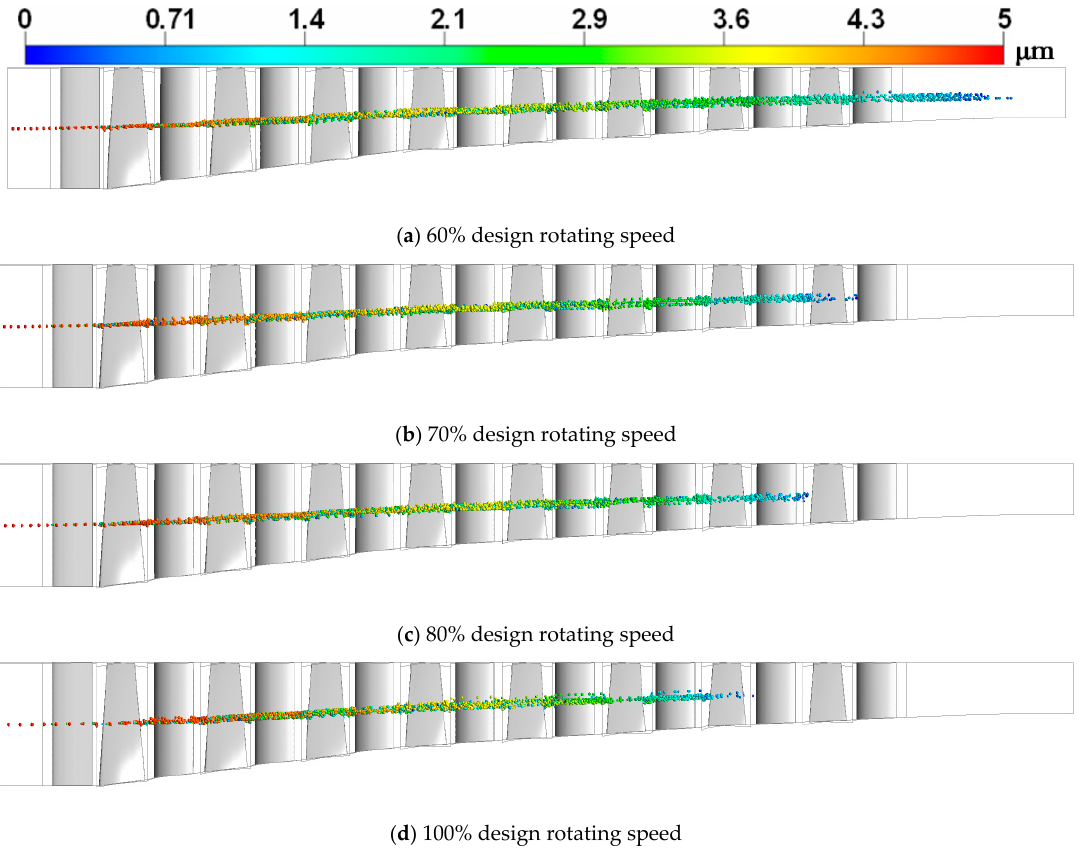
Figure 11. Droplets trajectories inject from inlet 50% span under the wet cases (RR size 5 µ m, injecting mass flowrate 0.5%).